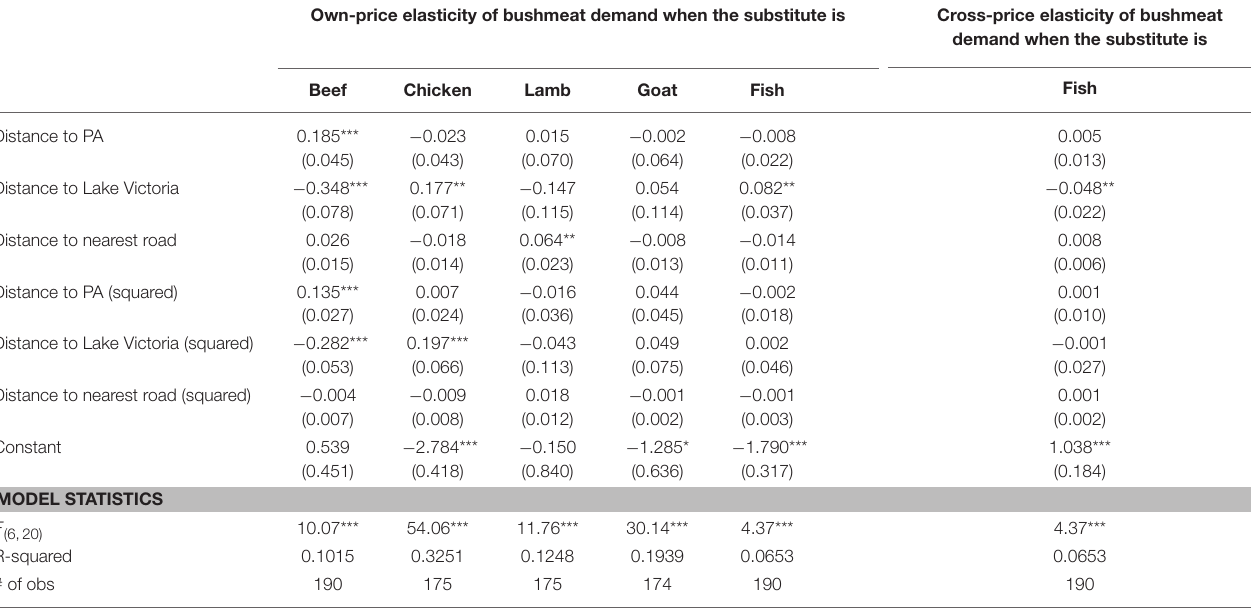
demand when the substitute is